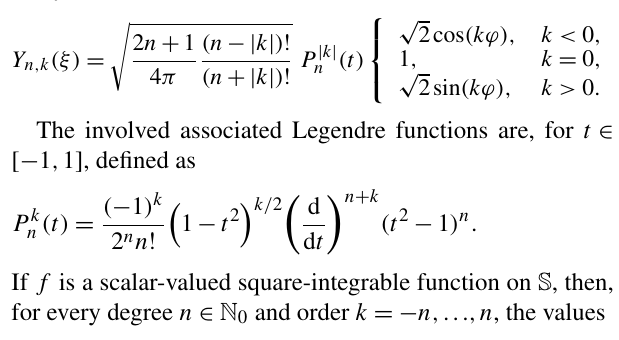
with 50th best localization over the oceans (a) and g ( 3 ) 50